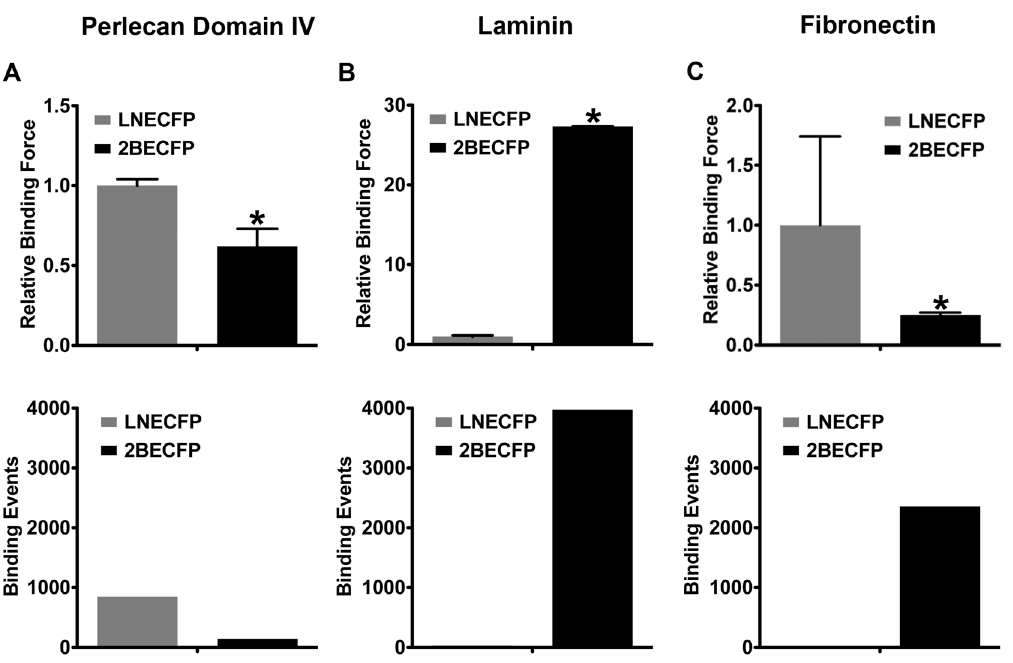
Figure 6. Fold binding force (A, B, C) and total binding events (D, E, F) of perlecan domain IV (A, D), laminin (B, E), and fibronectin (C, F) attached to an AFM tip engaged to either LNECFP or 2BECFP cells plated on a 60 mm tissue culture dish. A . When the AFM tip is coated with perlecan domain IV, vector control 2BECFP cells exhibit a 40% decrease in binding force relative to LNECFP cells (top panel, P , 0.05), and sustain nearly 700 less binding events than their LNECFP counterparts (bottom panel). B . LNCaP cells that overexpress beta-2 have a nearly 26 fold increase in average binding force to laminin over LNECFP cells (top panel, P , 0.05) and incur a massive amount of binding events compared to LNECFP cells (bottom panel). C . LNECFP cells have an increased average binding force relative to 2BECFP cells (top panel, P , 0.05) but exhibit a diminutive number of total events relative to 2BECFP cells when the AFM tip is coated with fibronectin (bottom panel). Fold binding force data presented as fold relative to LNECFP 6 normalized SEM (n=3). doi:10.1371/journal.pone.0098408.g006 While both LNECFP (Figure 1B) and 2BECFP (Figure 1A and associated with increased size and number of microvilli in 1C) cells are observed in close proximity to nerve, 2BECFP cells Xenopus oocytes [60] and augmented process length in PCa cells display beta-2 specific microvilli and likely to have an augmented [62]. Although not statistically significant, beta-2 protein expres- number of PCa cell:nerve contacts compared to LNECFP cells. sion levels appear to be coupled to an increased trend in PCa cell (Figure 1C, red arrows). Indeed, beta-2 overexpression is association with unmyelinated (Figure 3A) nerve axons. As two